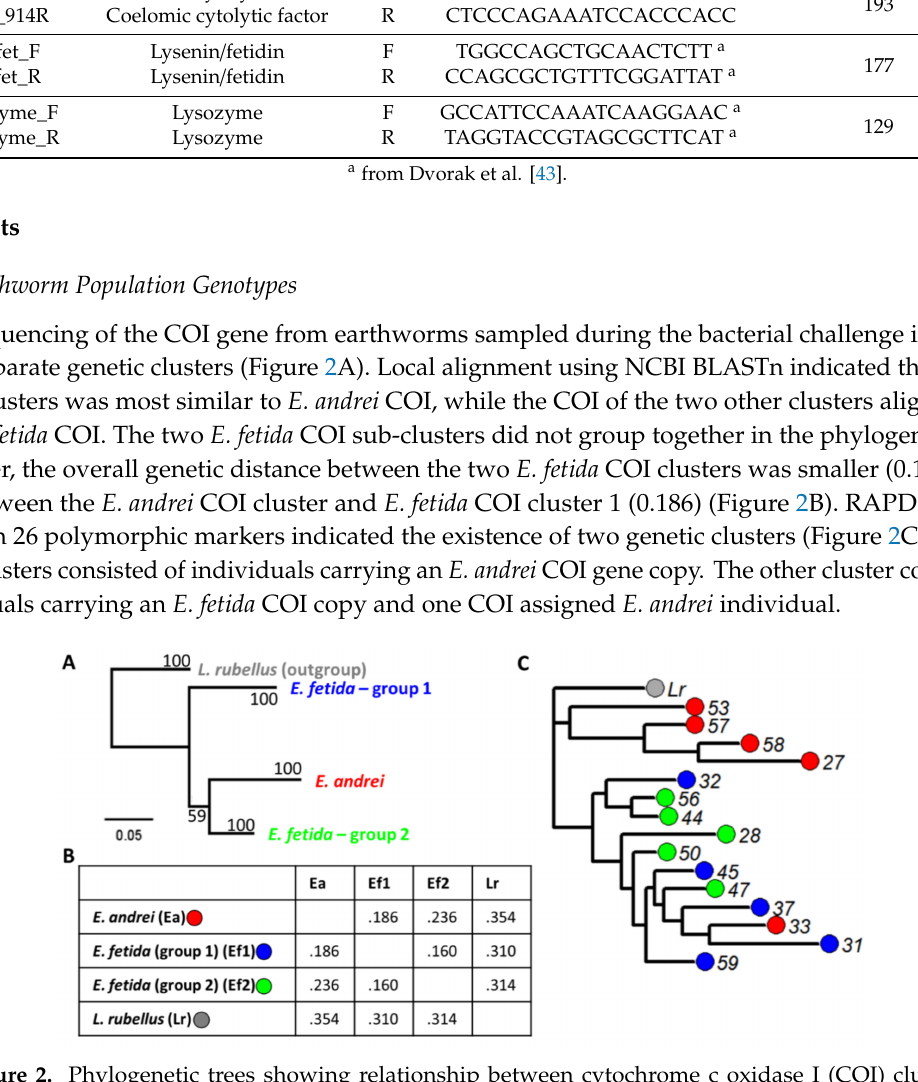
Figure 2. Phylogenetic trees showing relationship between cytochrome c oxidase I (COI) cluster and genetic distances between COI clusters. ( A ) Maximum-likelihood phylogenetic tree of showing phylogenetic relation between the three COI clusters. Samples are collapsed to COI cluster level, see Figure S2 for full tree. Bootstrap values are derived using 500 bootstraps. ( B ) Table with genetic distances between the three COI clusters. ( C ) Rooted neighbourhood-joining tree based on random amplification of polymorphic DNA (RAPD) profiles with L. rubellus ( Lr ) as outgroup. Di ff erent number indicate sample number. Colours indicate COI